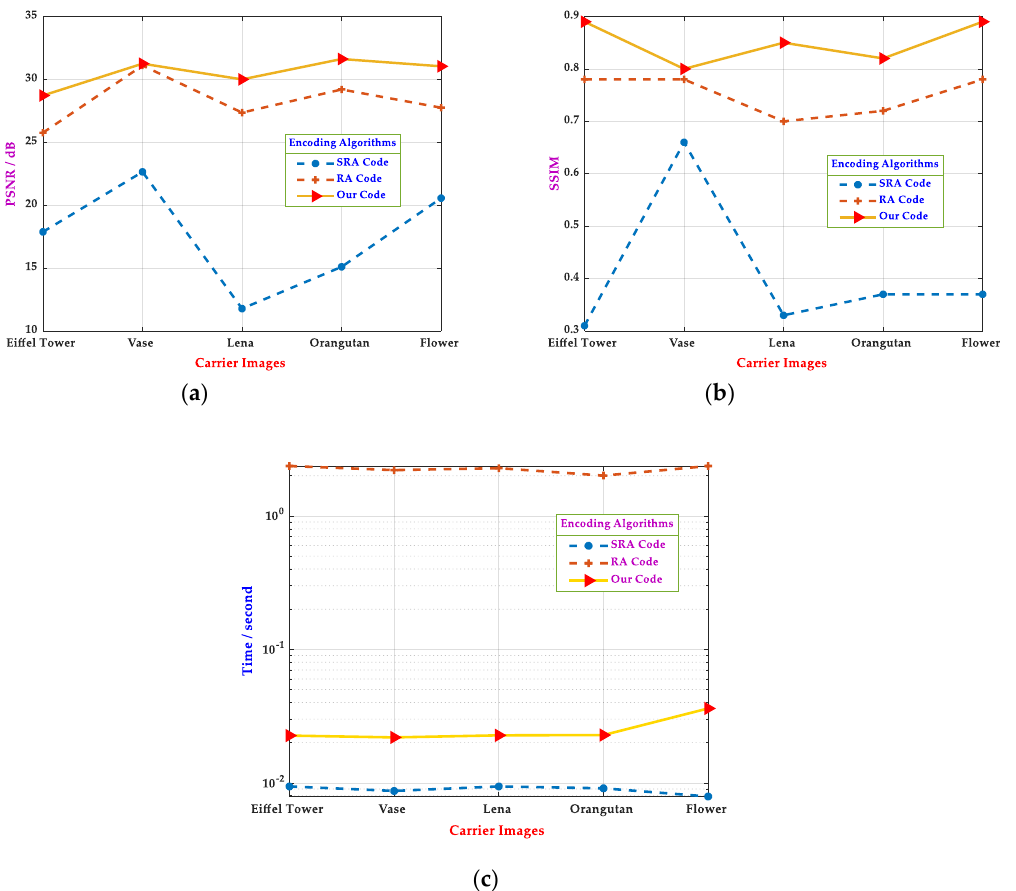
Figure 9. The perceptual quality and encoding time comparisons of aesthetic 2D barcodes with different carrier images. ( a ) The PSNR values of different carrier images when threshold = 10 . ( b ) The SSIM values of different carrier images when threshold = 10 . ( c ) The encoding time of different carrier images when threshold = 10 .